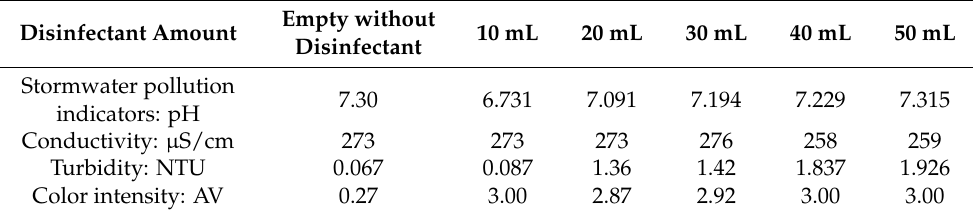
Table 5. The impact of disinfectants on stormwater pollution indicators. Empty Disinfectant Amount